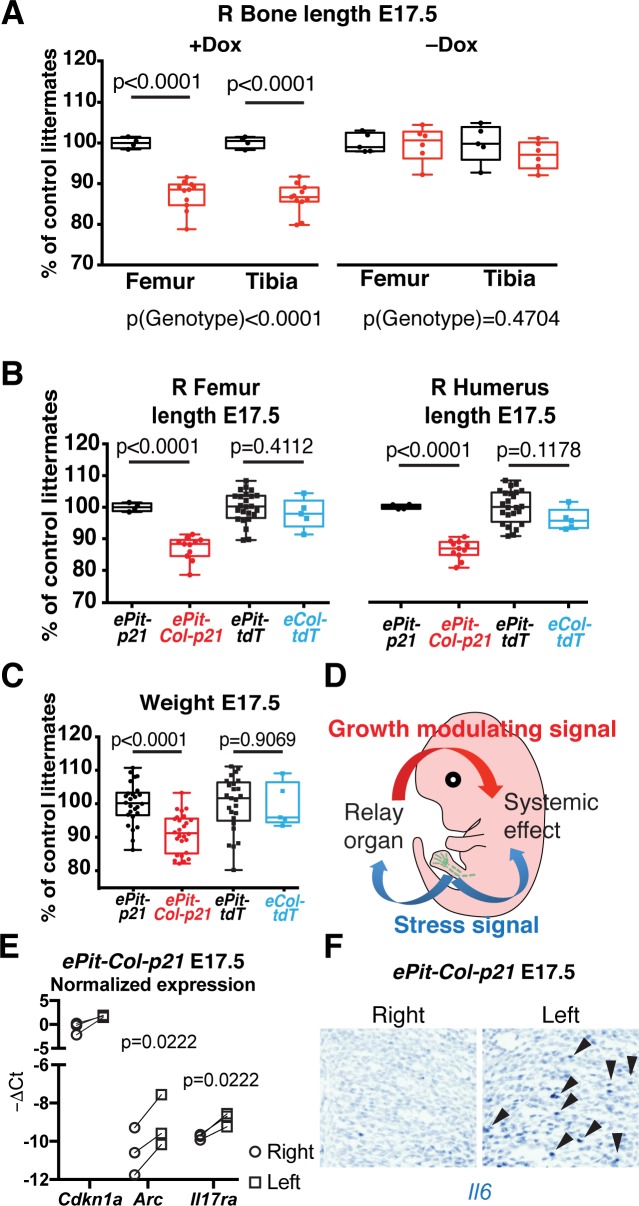
Mosaic local proliferation blockade in chondrocytes of the left limb results in systemic growth reduction.(A) Right femur and tibia length (normalized to the average ePit-p21 littermate) from E17.5 embryos treated with Dox (n = 4 ePit-p21 and n = 11 ePit-Col-p21) or untreated (n = 5 and n = 6). Comparison by 2-way ANOVA with Genotype and Bone identity as variables. p-Values for Genotypes are shown below graphs; p-values for Sidak’s post hoc test shown on graph. (B–C) Box and whisker plots for normalized bone length (panel B) and weight (panel C) of ePit-Col-p21 and Col2a1-rtTA; Igs7TRE-tdT/+ embryos (eCol-tdT, expressing tdT in all cartilage elements), compared to their controls (ePit-p21 and ePit-tdT) by unpaired t tests. p-Values corrected for multiple comparisons (Holm-Sidak method) are shown. For panel B, n = 22 ePit-p21, n = 26 ePit-Col-p21, n = 25 ePit-tdT, and n = 5 eCol-tdT). For panel C, n = 4, 11, 24, and 5. (D) Model of the systemic growth response after local chondrocyte arrest triggers a stress signal. (E–F) qRT-PCR (panel E) and in situ hybridisation (panel F) for the indicated transcripts in the proliferative plus pre-hypertrophic zone from ePit-Col-p21 embryos. Panel E shows one of 2 independent experiments with 3 distinct biological replicates each (total n = 6). The –ΔCt (relative to Gapdh) for each stress-related transcript was compared by a paired t test (left versus right). In panel F, n = 2 E15.5, n = 4 E16.5, and n = 6 E17.5 embryos (arrowheads denote Il6 expression). For panel A–C and E, see also S3 Data. Dox, doxycycline; E, embryonic day; qRT-PCR, quantitative real-time polymerase chain reaction; tdT, tdTomato.